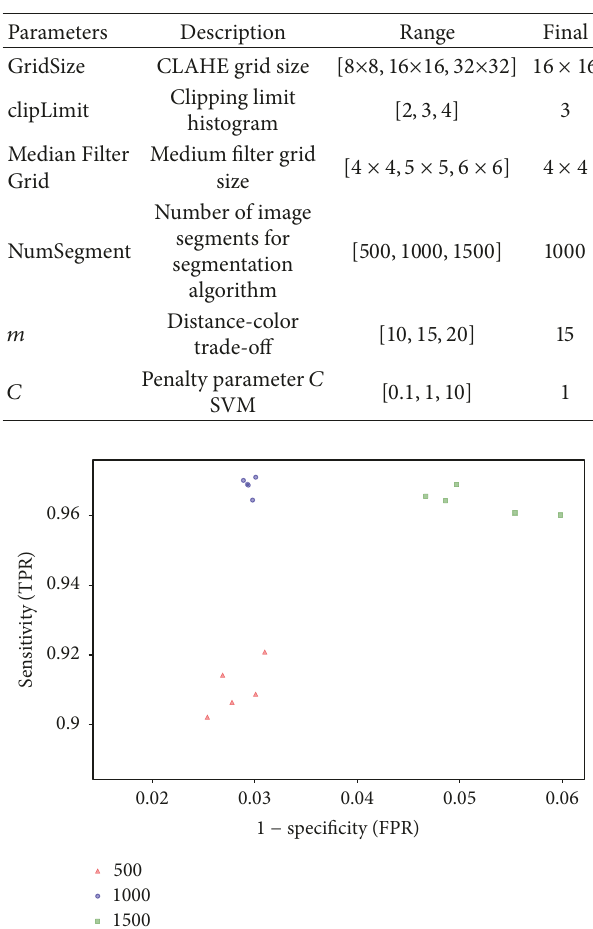
Table 1: Segmentation algorithm setting parameters.